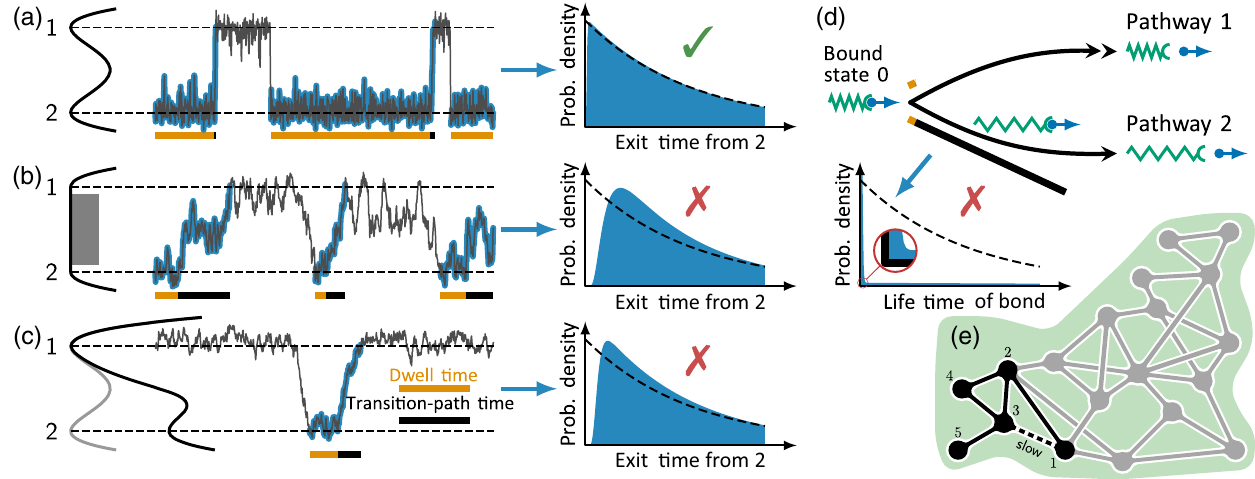
FIG. 1. Breakdown of Markovian and emergence of non-Markovian kinetics. (a) Left: diffusion in a double-well potential as a reduced model of the dynamics of a protein molecule transitioning between an unfolded (state 1) and a folded (state 2) conformation. Each exit event from state 2 to state 1 is highlighted in blue. Right: the histogram (shaded region) of the exit time from state 2 is well approximated by a memoryless single exponential decay (dashed line). Orange bars below the trajectory highlight dwell periods in the reduced state 2, and black bars the duration of transitions from state 2 to state 1. (b) Left: diffusion in a potential with a diffusive barrier. Right: the histogram (shaded region) of the exit time from state 2 alongside a single exponential decay with the same mean exit time (dashed line) that, however, only poorly approximates the statistics of exit. (c) Double-well potential from panel (a) “ tilted ” by an additional pulling force that destabilizes the (folded) state 2. (d) Schematic of rupture pathways of a “ catch bond ” under force. The bond can rupture along two possible pathways: a fast pathway 1 (double arrow) and a slow pathway 2 that involves an intermediate conformational change. As before, the orange and black bars denote the dwell and transition periods, respectively. The probability density of the lifetime of the bond is shown below, whereby the probability densities depicted by the histogram (shaded region) and dashed line have the same mean. The stark disagreement between the two reflects that the rupture is not memoryless. (e) Schematics of a general network with a subnetwork with five states highlighted in black. Transitions between states 1 and 3 (dashed line) are assumed to be